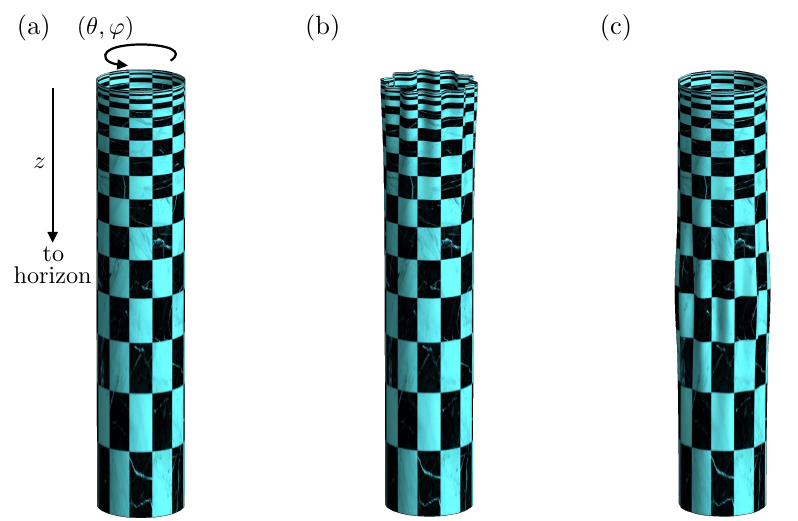
Figure 1 . Illustration of spatial slices of our AdS 2 × S 2 solution and perturbations, with one of the two angular directions suppressed. (a) The unperturbed solution, with boundary at z = 0 and Poincaré horizon at z = ∞ . (b) A perturbation near the boundary. (c) A perturbation deeper in the bulk. We will fully categorize the propagating modes, solving the Regge-Wheeler-Zerilli problem in this geometry and diagonalizing the mass